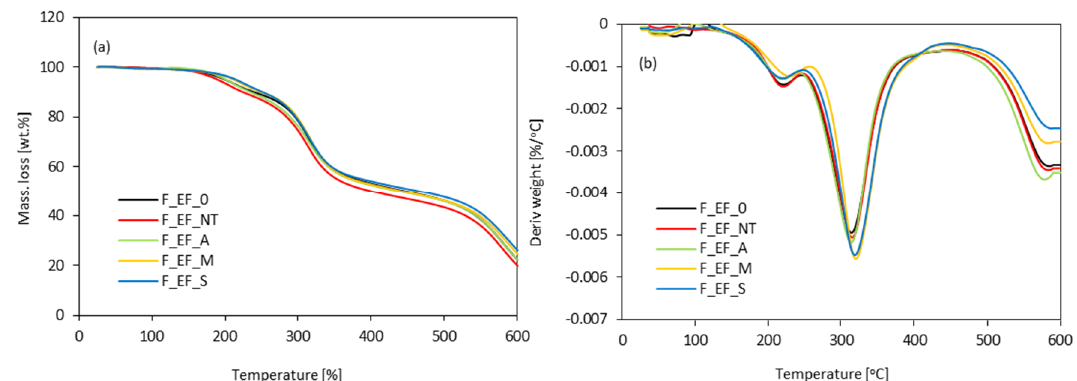
Table 5. The results of thermogravimetric (TG) and DTG analysis.